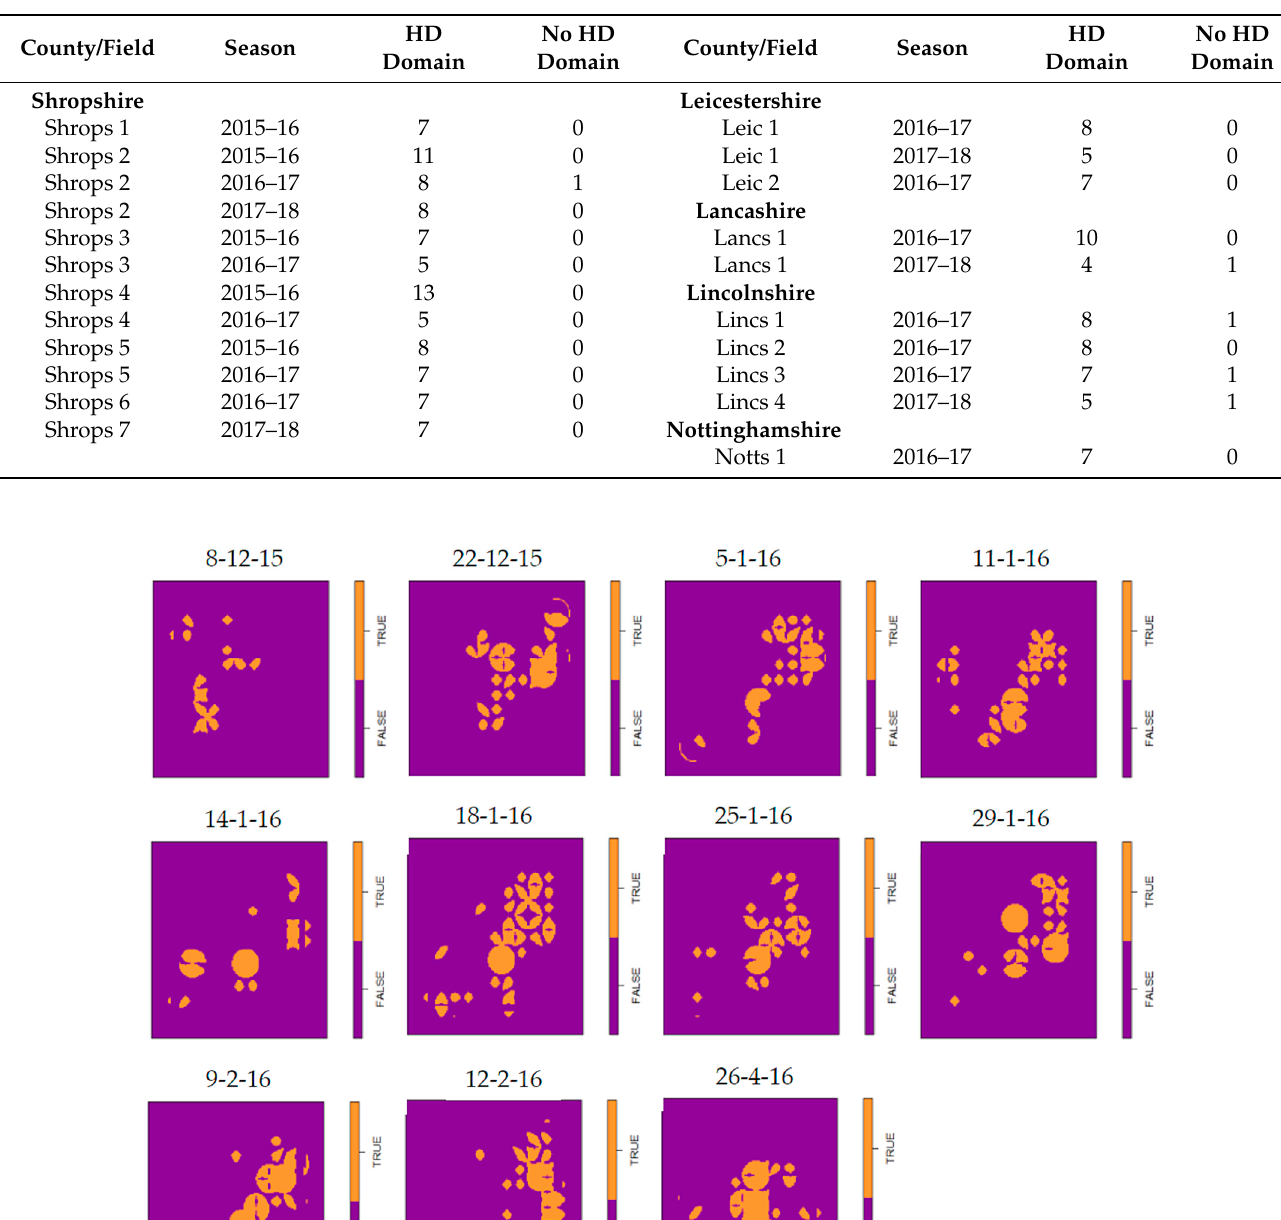
were identified using hotspot analysis and visualized using grid maps (Table 3; Figure 4; Figures S1–S22). Table 3. The number of assessment visits to each field in which hot spot analysis identified discrete domains containing significantly higher slug density ( p < 0.05; HD) when compared with that expected if the population was randomly distributed across the sampling grid. Assessments made using a 10 by 10 grid of refuge traps set within a rectangular 1ha plot.